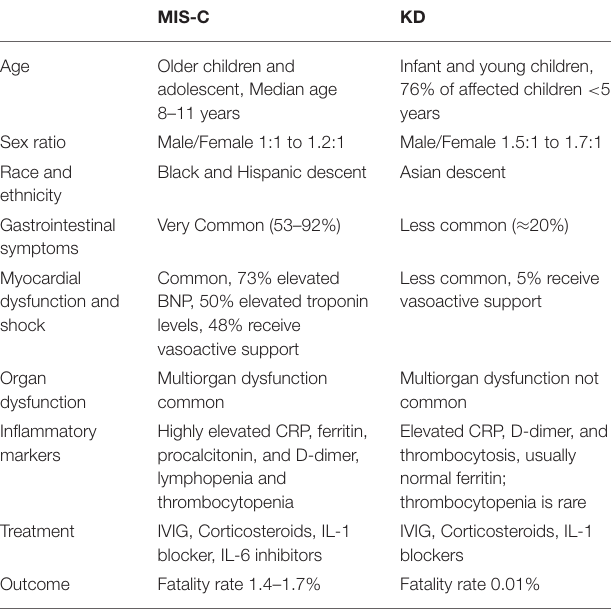
TABLE 2 | Difference between multisystem inflammatory syndrome in children and Kawasaki disease ( 18, 19,